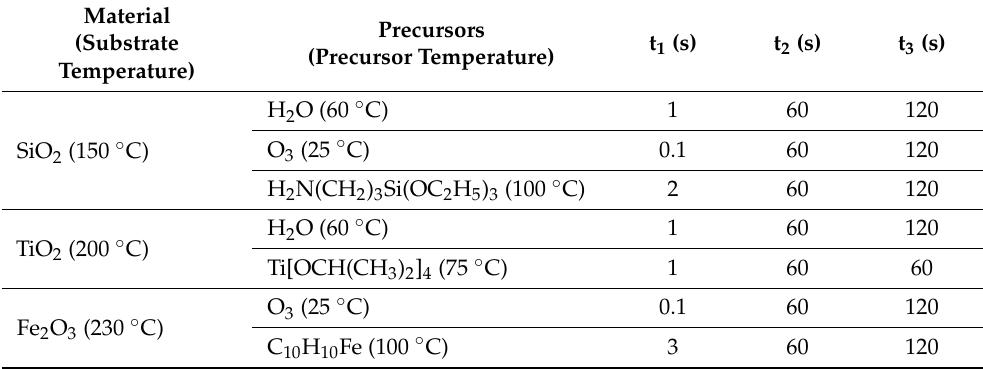
Table 1. Times and temperatures employed in the ALD processes for the different coating materials, where t 1 is the precursor pulse time; t 2 is the exposition time; and t 3 is the purge lapse. For each material, the times used in the exposure to each precursor are shown by columns, whereas the precursor and substrate temperatures are indicated by